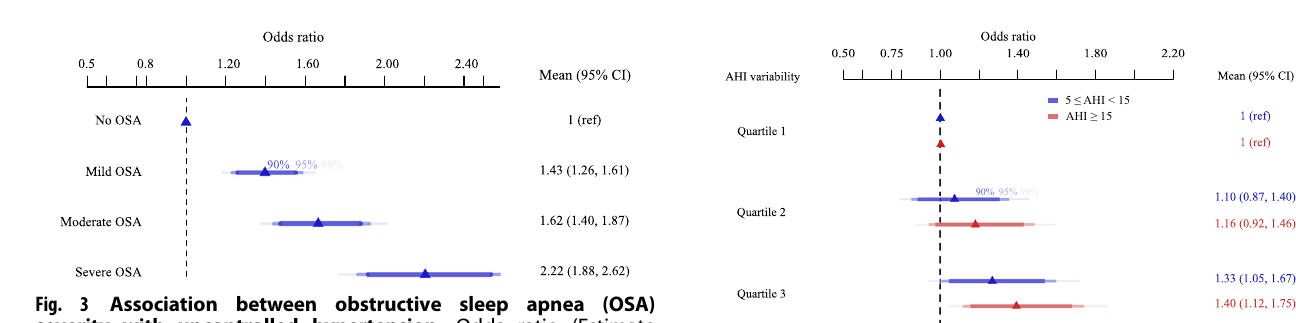
Fig. 2 Association between mean apnea – hypopnea index, apnea – hypopnea index variability and hypertension. Marginal probability of hypertension in relation to: a mean apnea – hypopnea index and b apnea – hypopnea index variability.